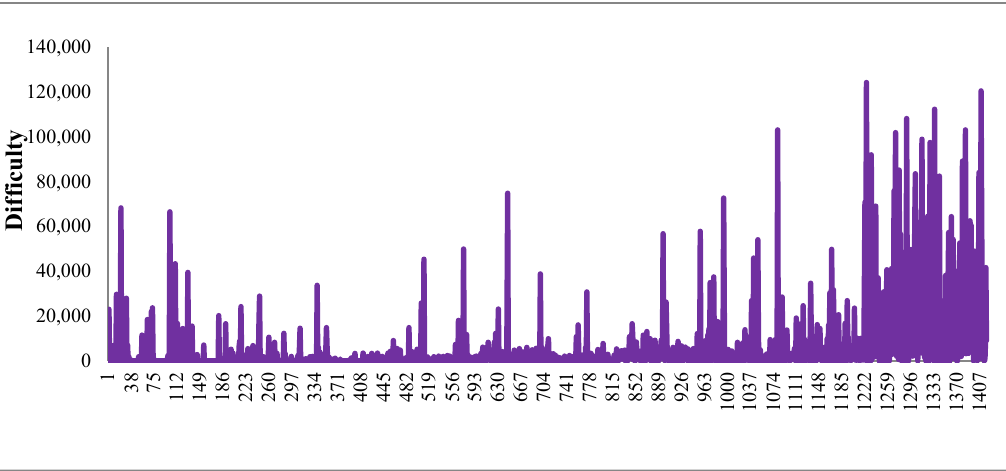
Figure 6. Difficulty of every slot allocation while objective function not including difficulty cost.